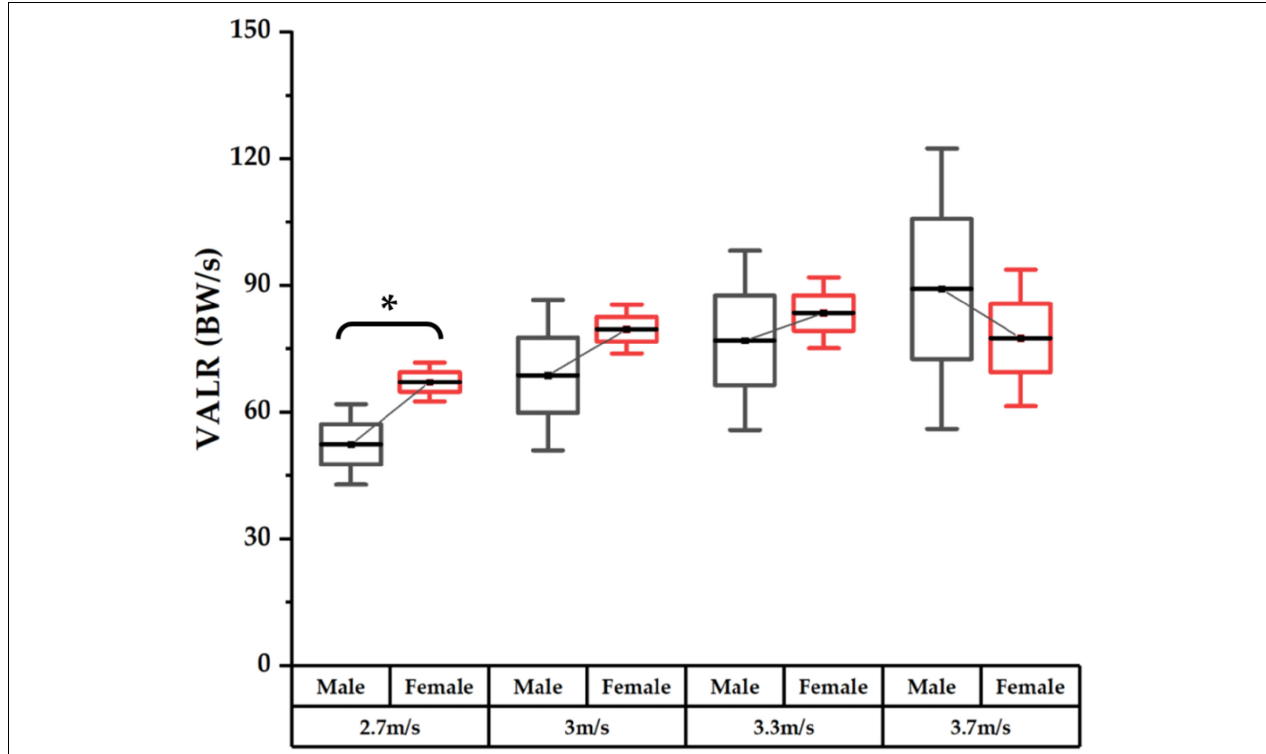
FIGURE 2 | Comparison of vertical average loading rates (VALRs) between male and female runners across different speeds with mean, 25–75th percentile, and SD values and highlighted significance with an asterisk (*).